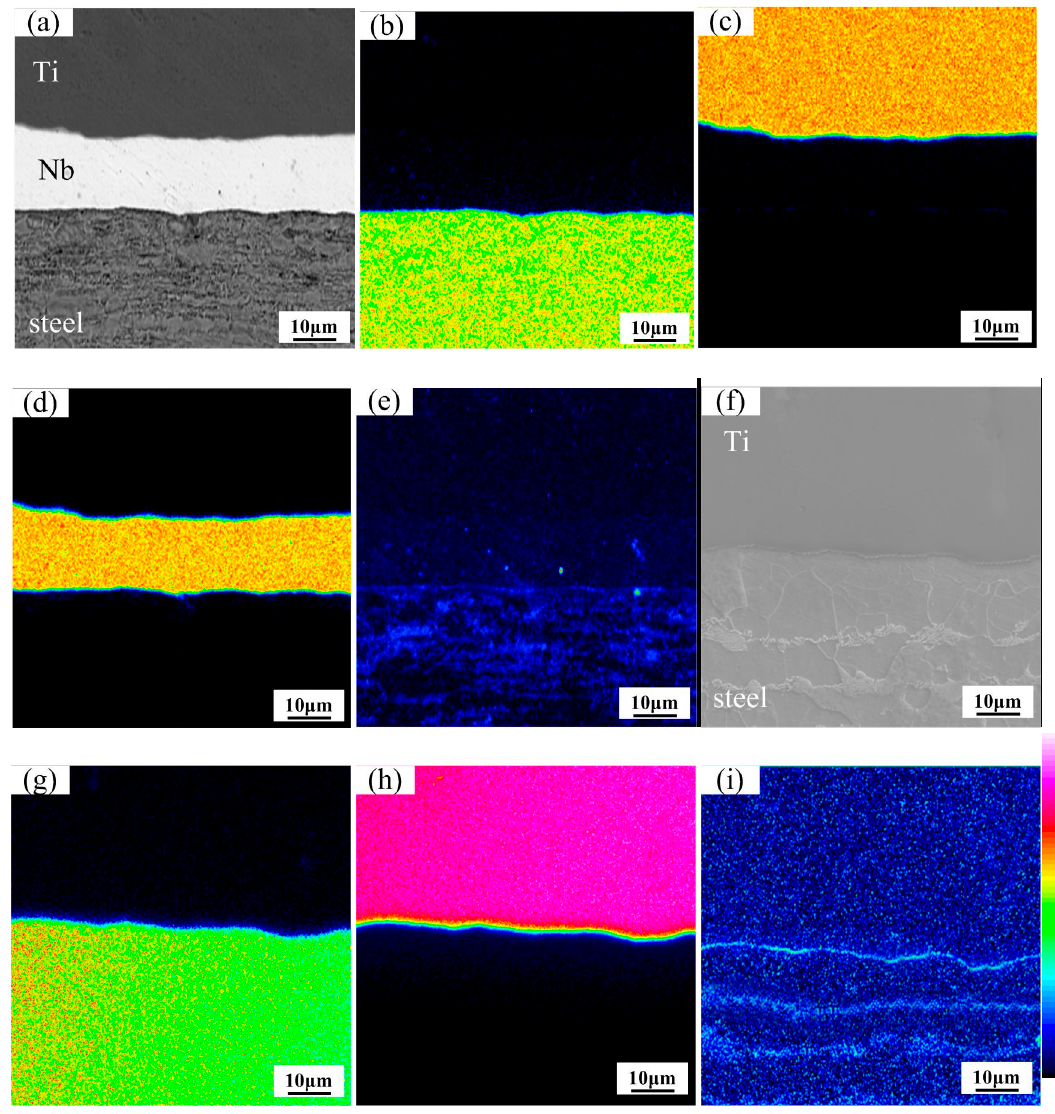
Figure 5. Map distribution micrographs of various elements at the interfaces at 800 °C: ( a ) BSE image; ( b ) Fe element; ( c ) Ti element; ( d ) Nb element and ( e ) C element for Ti/Nb/steel clad plate; ( f ) BSE image; ( g ) Fe element; ( h ) Ti element and ( i ) C element for Ti/steel clad plate.